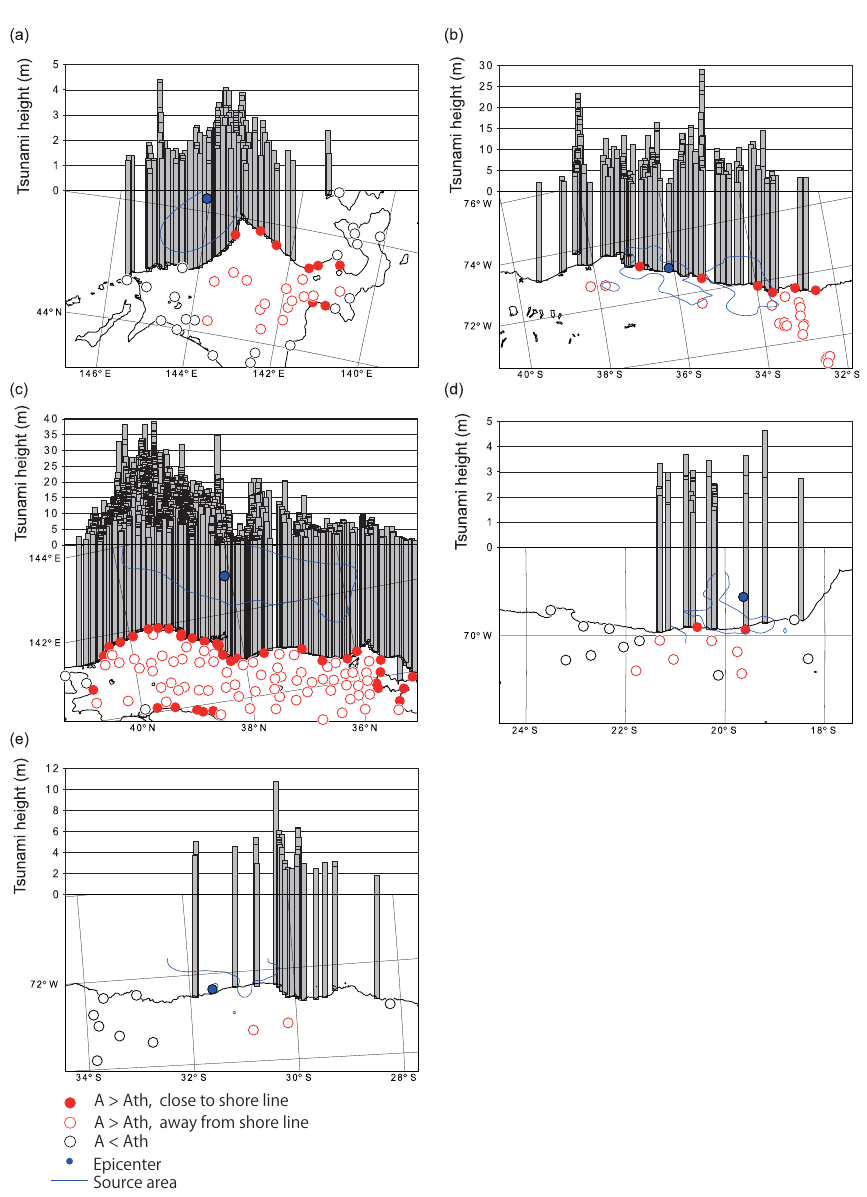
Figure 5. Map plot of the observational values for major earthquakes: (a) the 2003 Tokachi-oki earthquake ( M w 8.3), (b) the 2010 Maule Earthquake ( M w 8.8), (c) the 2011 Great East Japan Earthquake ( M w 9.1), (d) the 2014 Iquique earthquake ( M w 8.1), and (e) the 2015 Illapel earthquake ( M w 8.3). Color is classified according to observed amplitude ( A ) compared with threshold value ( A th ). The observed tsunami run-up heights are also